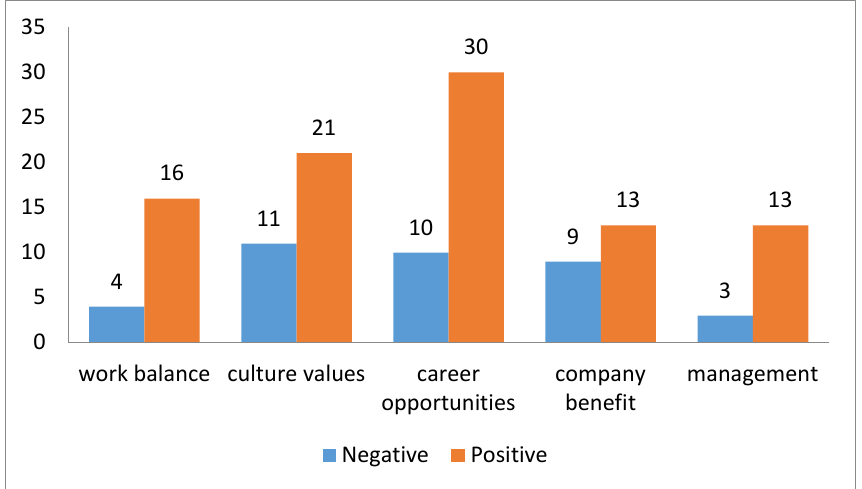
Fig. 5 Aspect score of each aspect from Amazon company’s